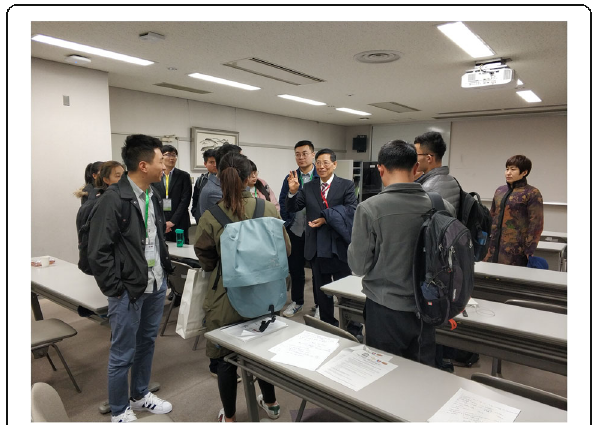
Fig. 7 Discussion between Professor Manchao He and students after the presentation